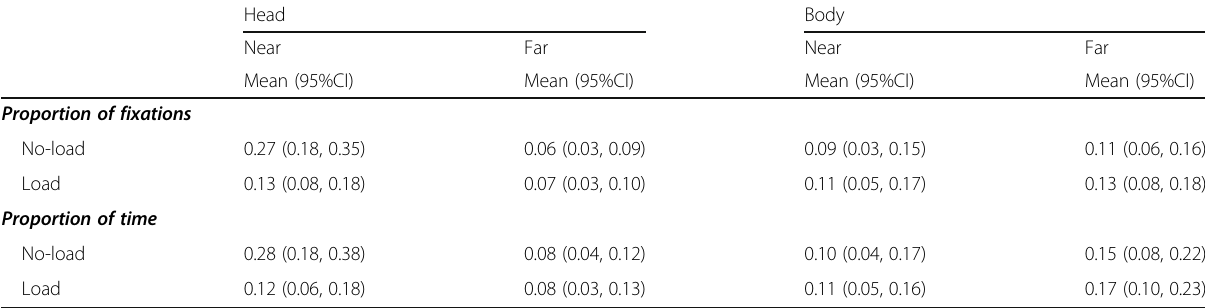
Table 7 Proportion of fixations toward the head and body for Condition (no-load, load) and Proximity (near, far) in Experiment 3 Head Body Near Far